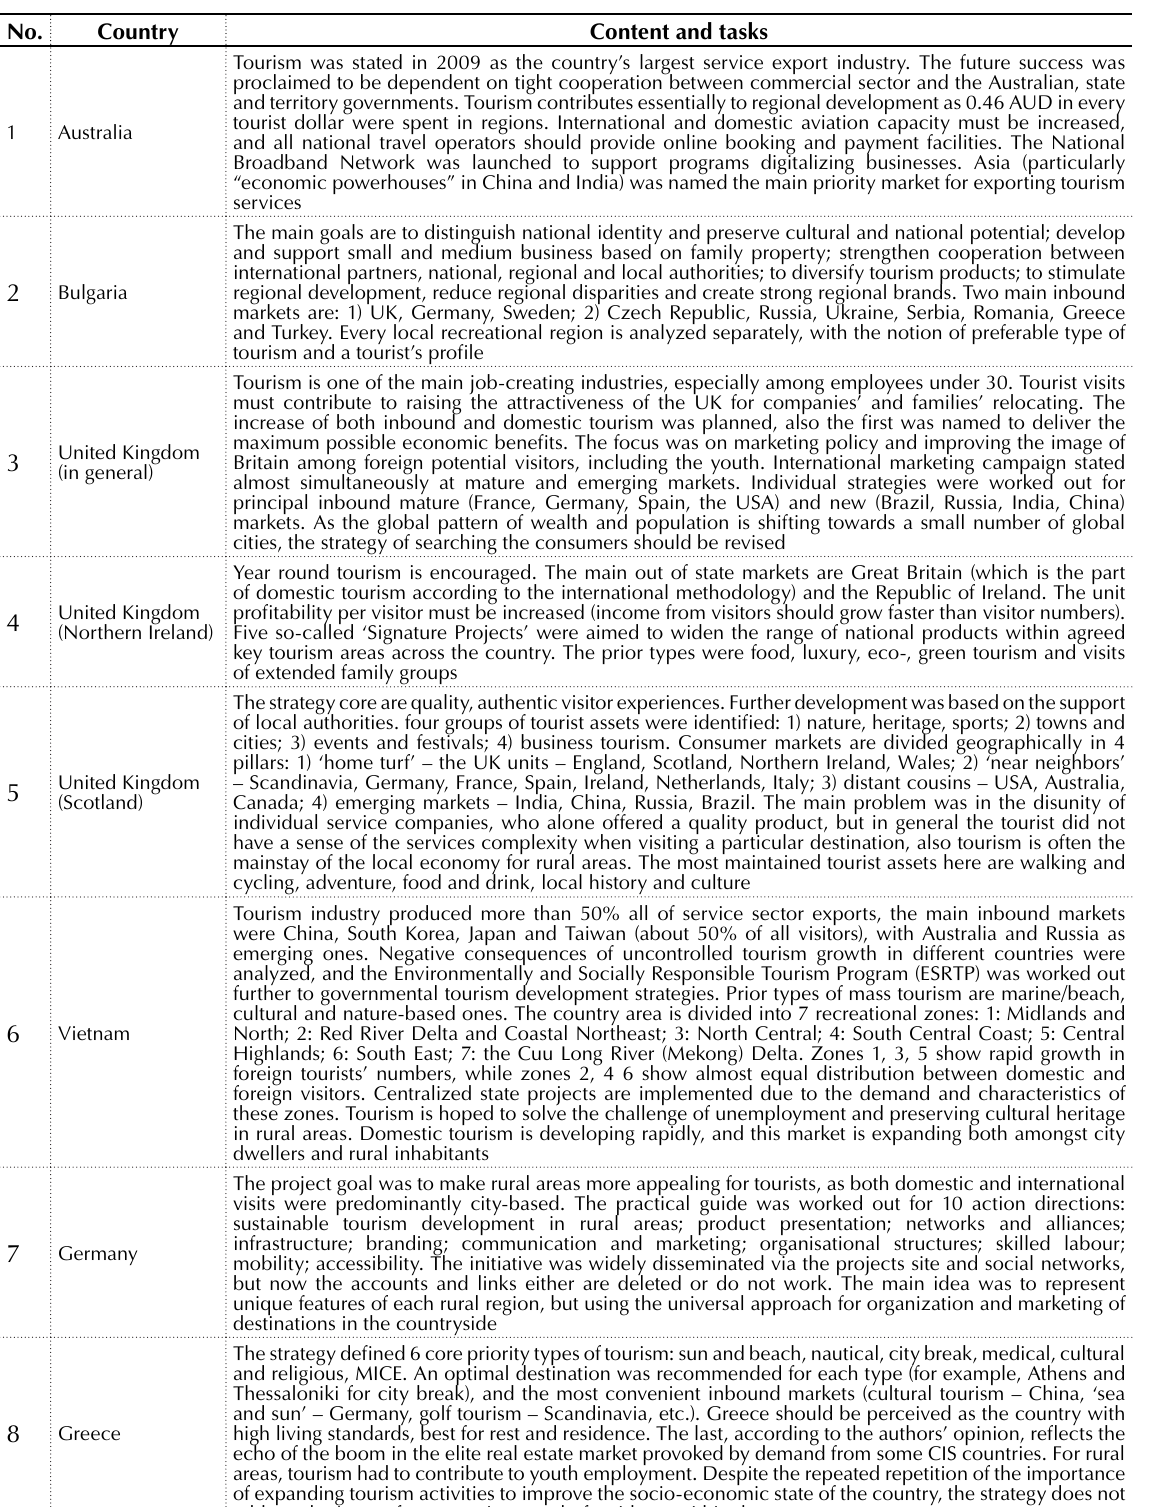
Table B1. The content of state programs and investment proposals (mentioned in Table 5 of the main